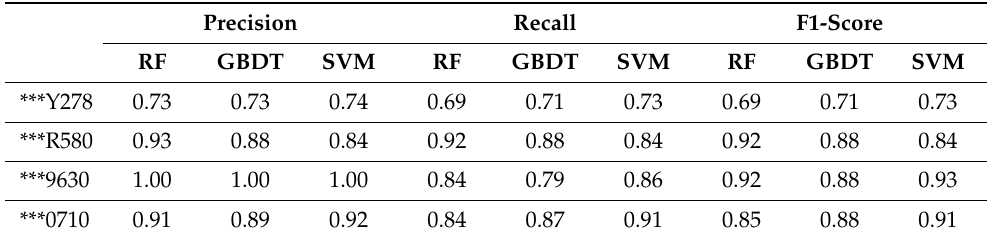
Table 3. The evaluation results for the prediction-based approach to identifying excessive emissions (note that we use “*” to replace some letters or